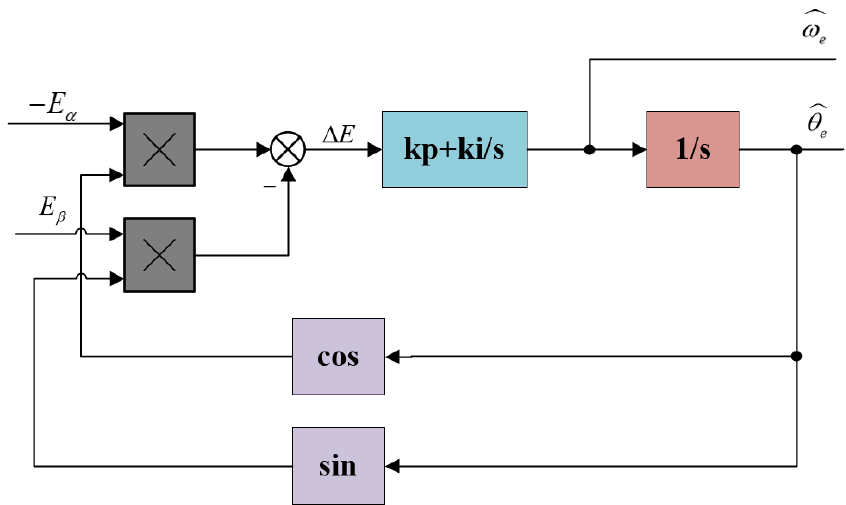
Figure 4. PLL structure block diagram.